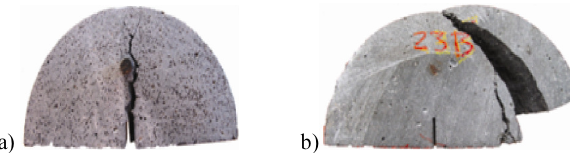
Fig. 7. Semi-Circular Bending Test (SCB): a) Proper SCB test; b) Failed SCB test